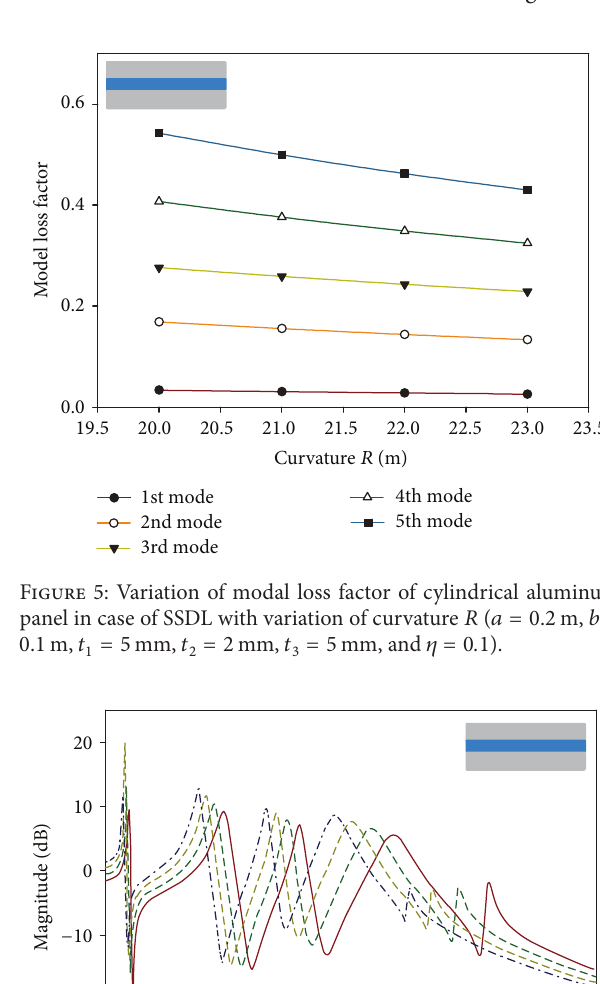
Figure 4: Variation of natural frequencies of cylindrical aluminum panel in case of SSDL with variation of curvature 𝑅 ( 𝑎 = 0.2 m, 𝑏 = = 5 mm, 𝑡 = 2 mm, 𝑡 = 5 mm, and 𝜂 = 0.1 ). 0.1 m, 𝑡 1 2 3